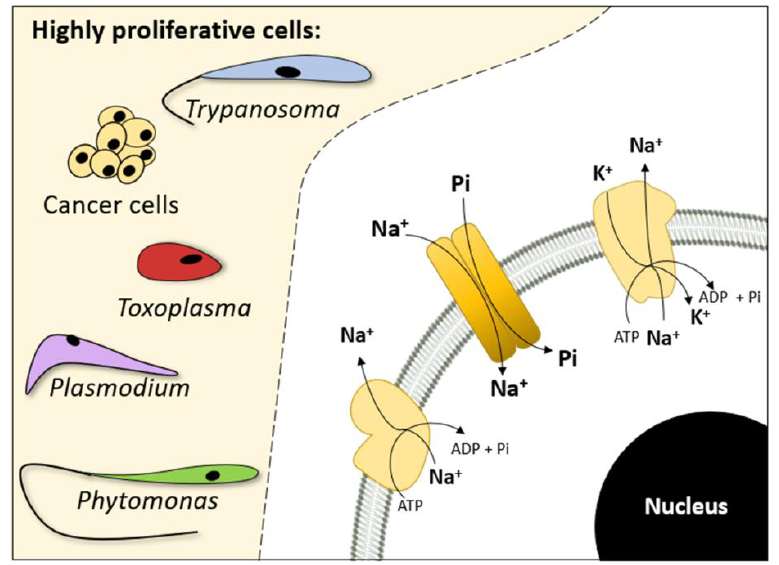
Figure 3. Na + -dependent Pi transport mechanisms in highly proliferative cells. Na + -ATPase and Na + , K + -ATPase are coupled to Na + -dependent Pi transport in Trypanosoma cruzi , T. rangeli, cancer cells